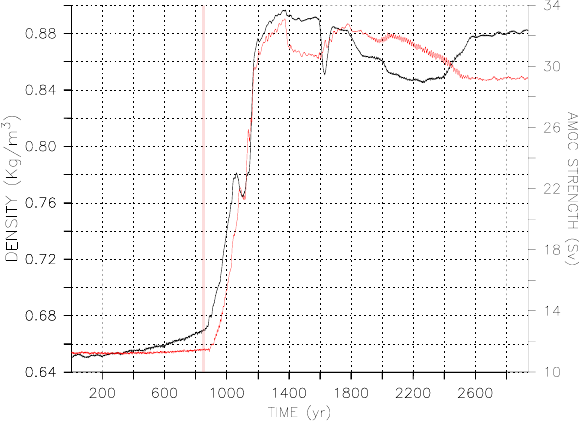
Fig. 8. Temporal evolution of the meridional north-south density contrast in kgm − 3 , estimated as the density difference between the North Atlantic (35 ◦ N–80 ◦ N, 60 ◦ W–10 ◦ E) and the South At- lantic (40 ◦ S, 60 ◦ W–10 ◦ E) at 750m depth (black line) and AMOC strength in Sv (red line), for the CO 2 -only experiment. The red shaded bar indicates the CO 2 -only transition stage. Table 1. Surface freshwater fluxes balance in myr − 1 over the